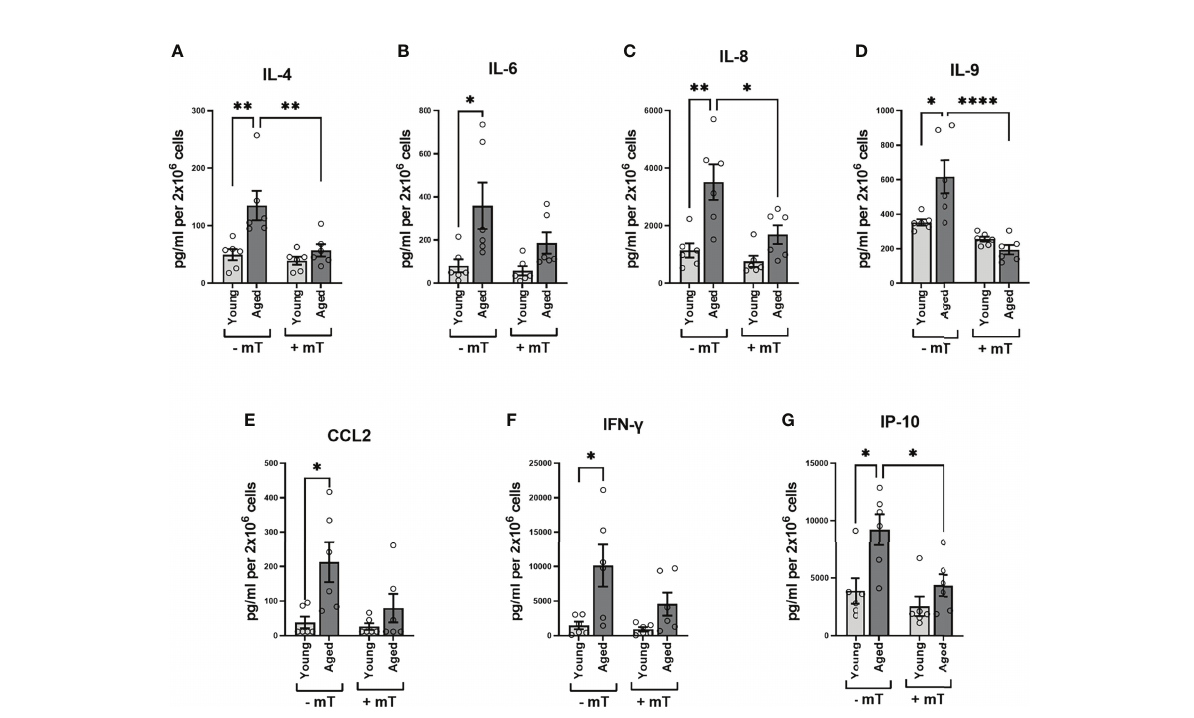
FIGURE 7 Cytokine secretion of memory CD4 + T cells. (A – G) Analysis of cytokine secretion in the supernatant of memory CD4 + T cells 24 h after TCR stimulation without and with mitoTEMPO(mT)-mediated reduction of cytokine secretion (mean ± SEM; n = 8). Mann-Whitney test was performed. *P<0.05,